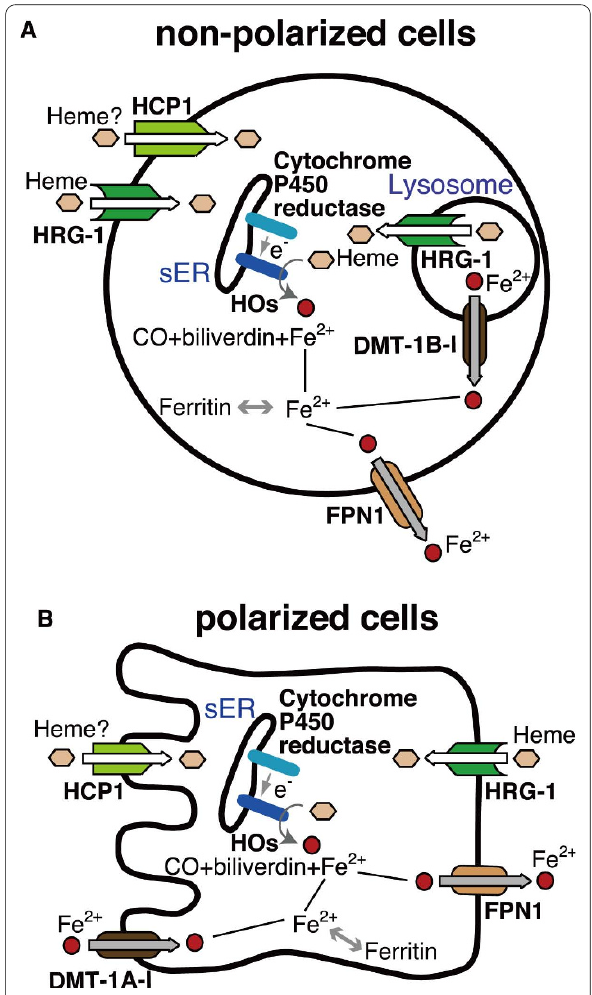
Figure 7 Summary of heme and iron transport . Schemas A and B indicate the possible mechanisms of heme transport and catabolism in non-polarized and polarized cells, respectively. See Discussion and Conclusion for further